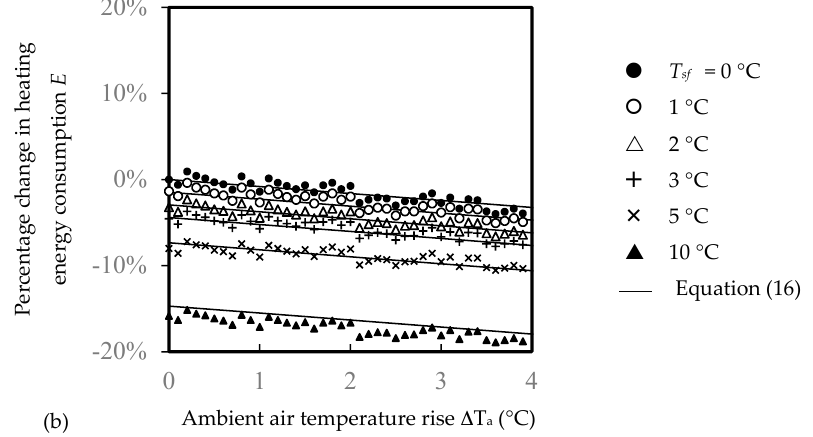
Figure 4. Percentage change in heating energy consumption against ambient air temperature rise: ( a ) Behavioural responses related to taking fewer hot showers; ( b ) Behavioural responses to a positive temperature shift.